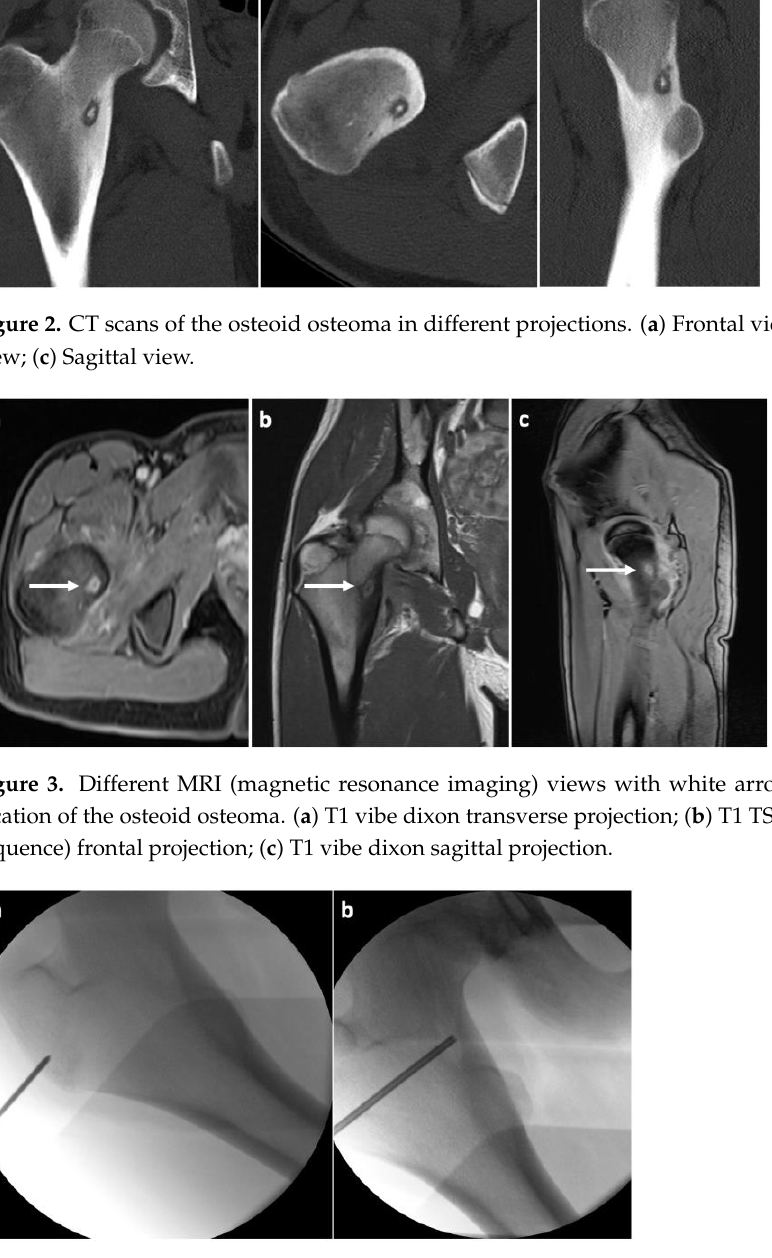
Figure 4. Intraoperative X-ray of the proximal femur showing: ( a ) the insertion point of the Kirschner wire; ( b ) the position of the working cannula in the osteoma (the slightly brighter irregular oval